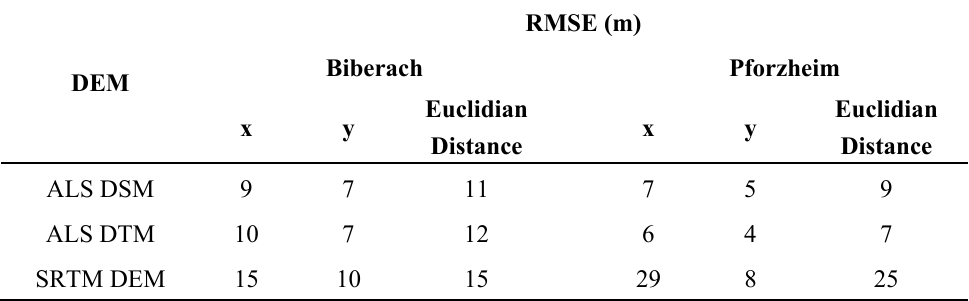
Table 2. Location accuracy of leaf-off synthetic aperture radar (SAR) images orthorectified with three different digital elevation models